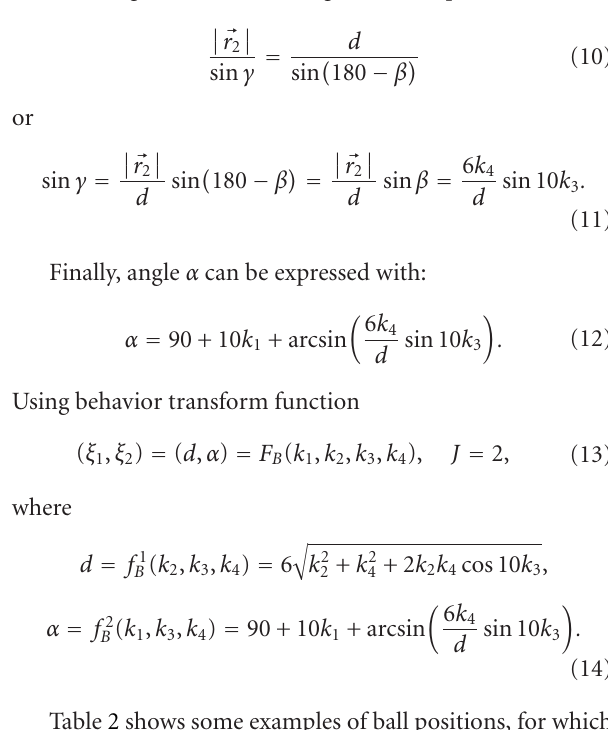
Table 2: Description examples of behavior sequence of actions.